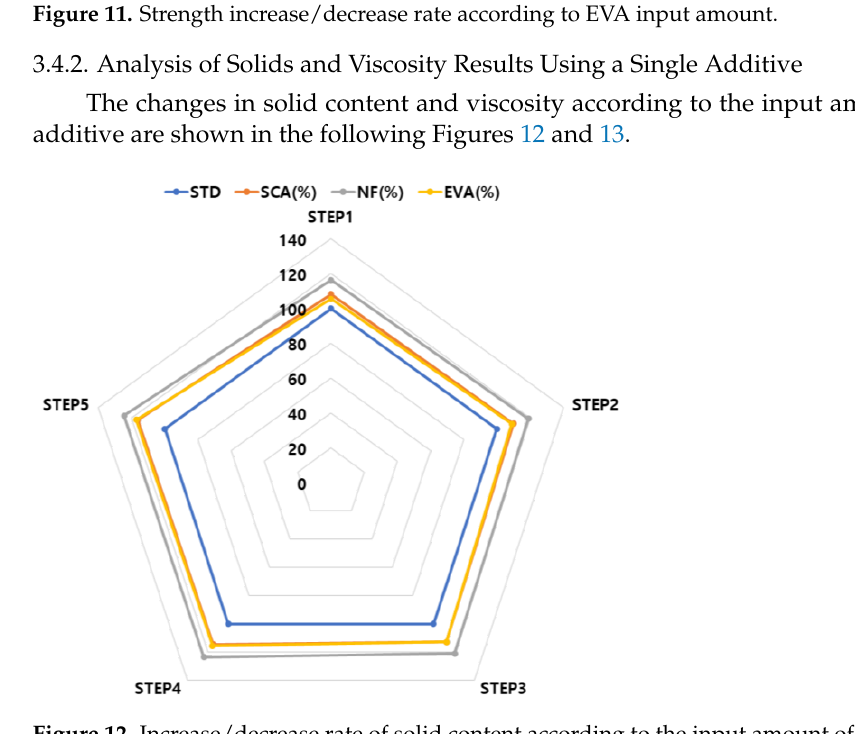
Figure 11. Strength increase/decrease rate according to EVA input amount.